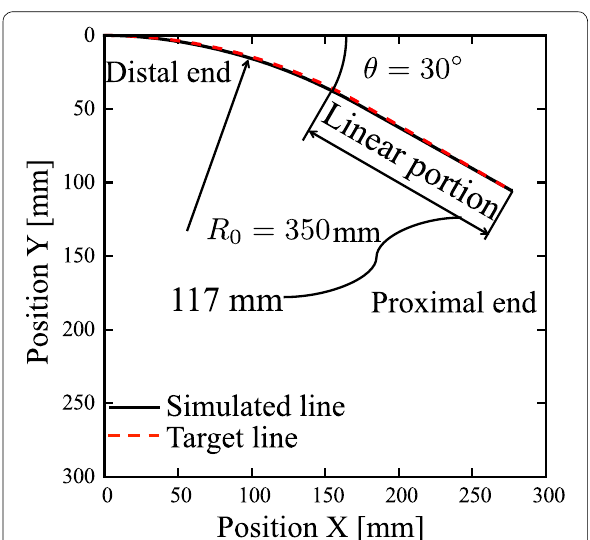
Fig. 9 Simulation results of the 3.5 mm inner pipe